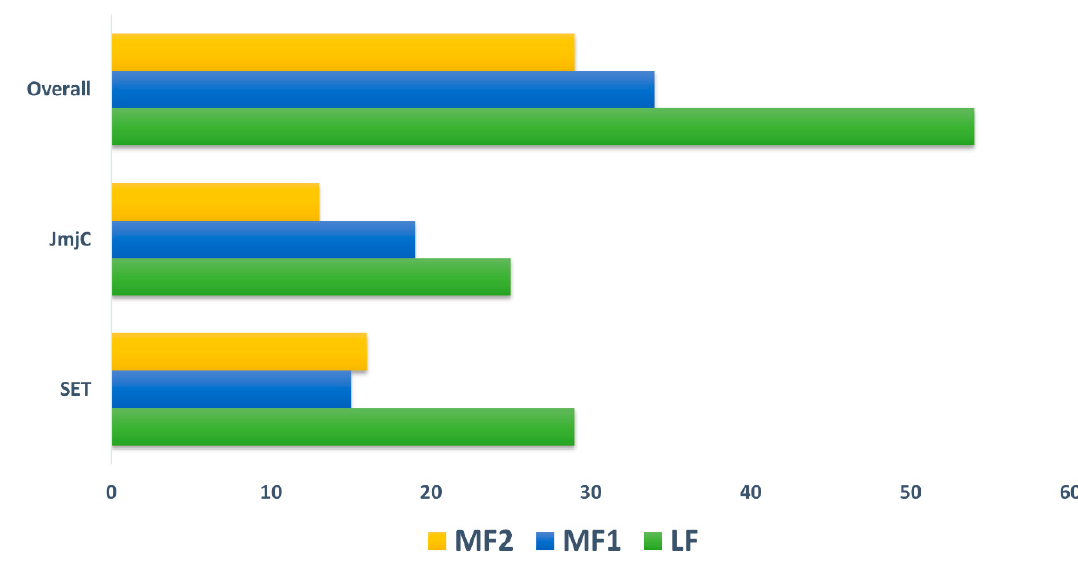
Figure 2. The ratio SET and JmjC, and their overlap among three subgenomes (i.e., LF = Least fractionated, MF1 = Medium Fractionated and MF2 = Most Fractionated genome) of B. rapa .